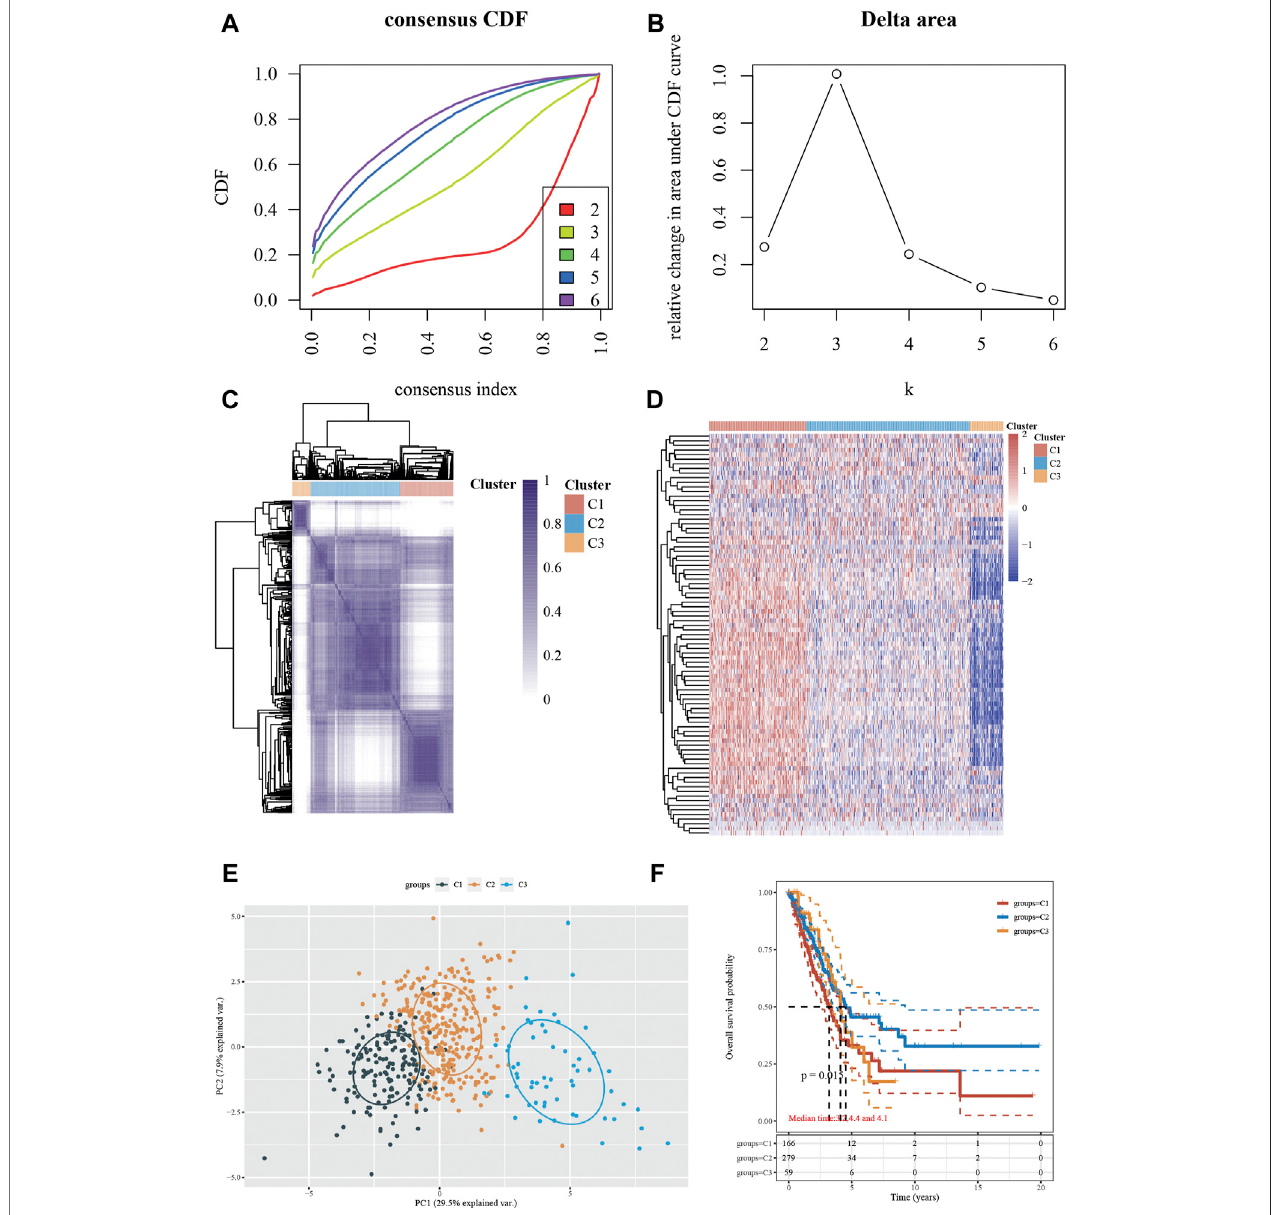
FIGURE3| Identi fi cationoftheStressGranuleSubtypesinNSCLC. (A – C) Unsupervisedclusteringoftheexpressionof60stressgranule-relatedgenesdividedall NSCLC cases into three groups (SGRGs). (D) Heatmap analysis showed the expression of stress granule-related genes in 3 clusters. (E) PCA analysis of all samples in three clusters. (F) Kaplan-Meier curves of overall survival for patients with NSCLC in three subtypes.